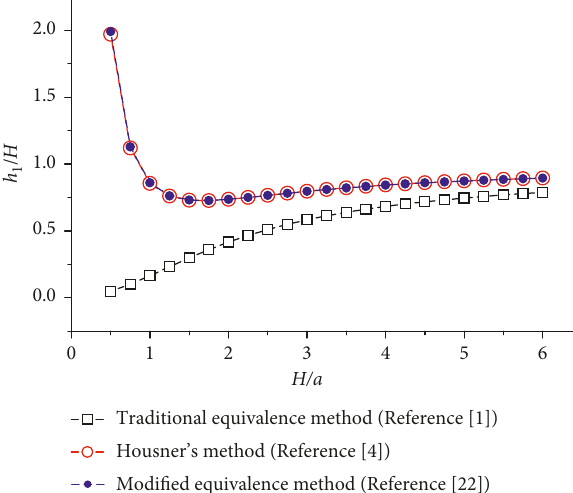
Figure 7: The first nondimensional sloshing frequency ω 2 H / a the fluid depth ratio H / a (rectangular tank).